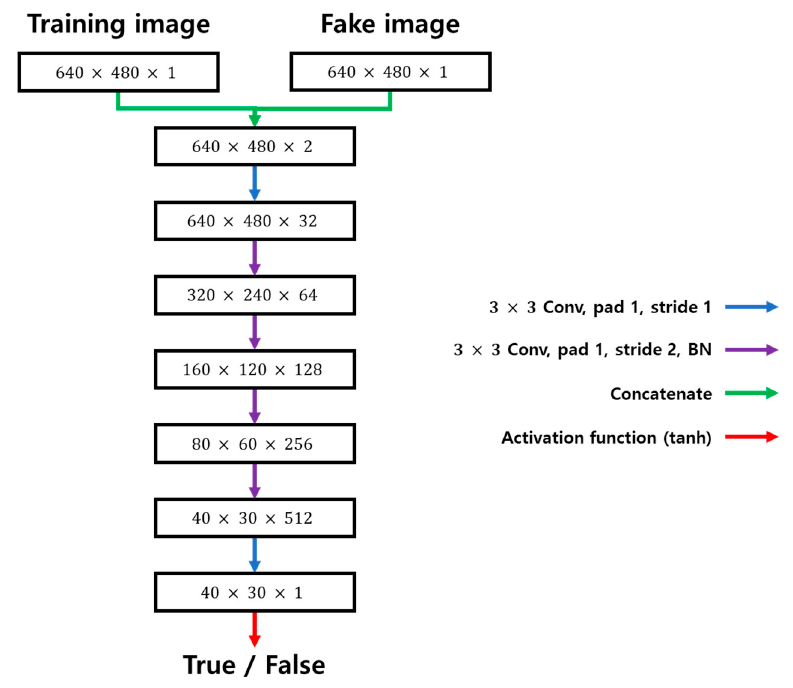
Figure 4. Structure of the discriminator applied in this study.